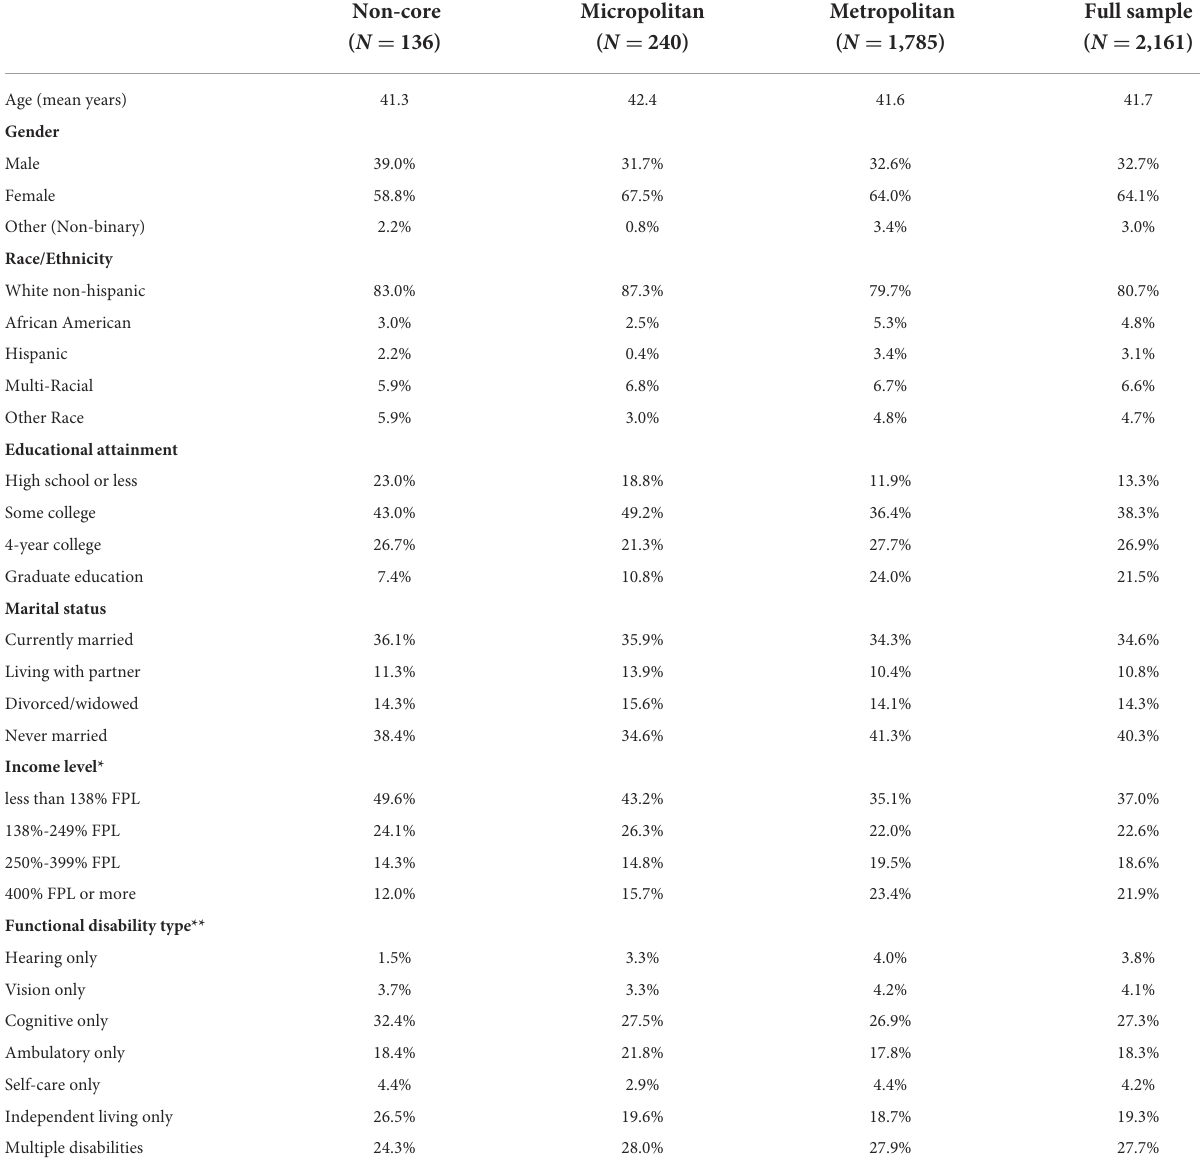
TABLE 1 Participant